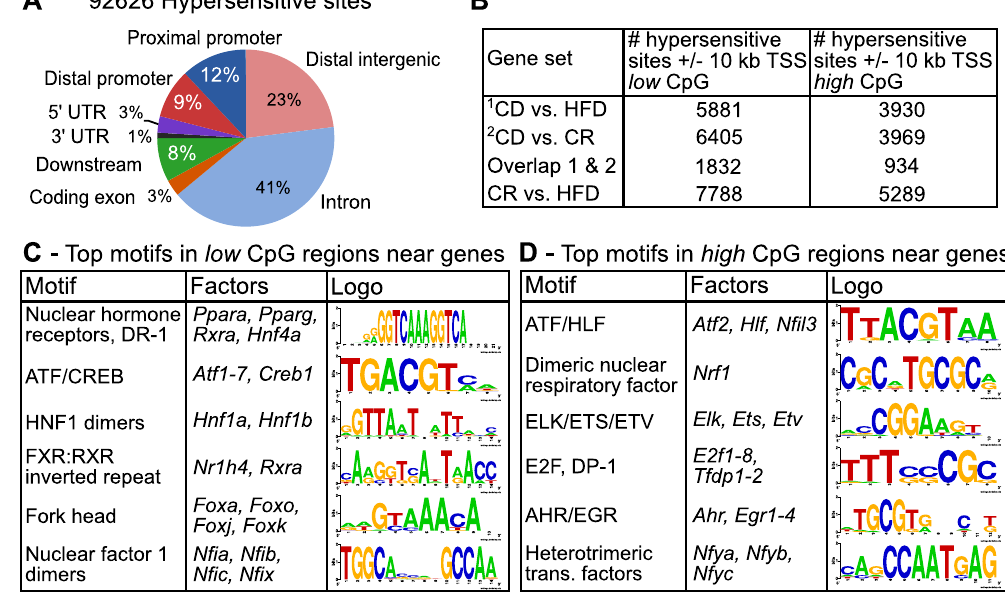
Figure 2. DNase-Seq reveals regulatory regions across liver genomes and motif analyses identify potential transcriptional regulators. ( A ) We found 92,626 hypersensitive regions among CD, HFD, and CR livers. The majority of identified sites reside within annotated gene introns (41%) as well as other near-gene locations. Regions were mapped near genes according to: proximal promoters – within 200 bp of gene TSS; distal promoters – within 5 kb upstream of gene; downstream – within 5 kb downstream of gene end; introns, exons, 5 ′ UTR, and 3 ′ UTR – if region intersected one of these features; and distal intergenic – outside 5 kb window around gene. ( B ) The numbers of identified hypersensitive regions near differential gene sets (first column) within + / − 10 kb of gene transcription start sites (TSS) in low (middle column) and high (right column) CpG content sequence sets are presented. ( C,D ) The most enriched DNA binding motifs (see Table S2) near all gene sets are shown for low ( C ) and high ( D ) CpG content